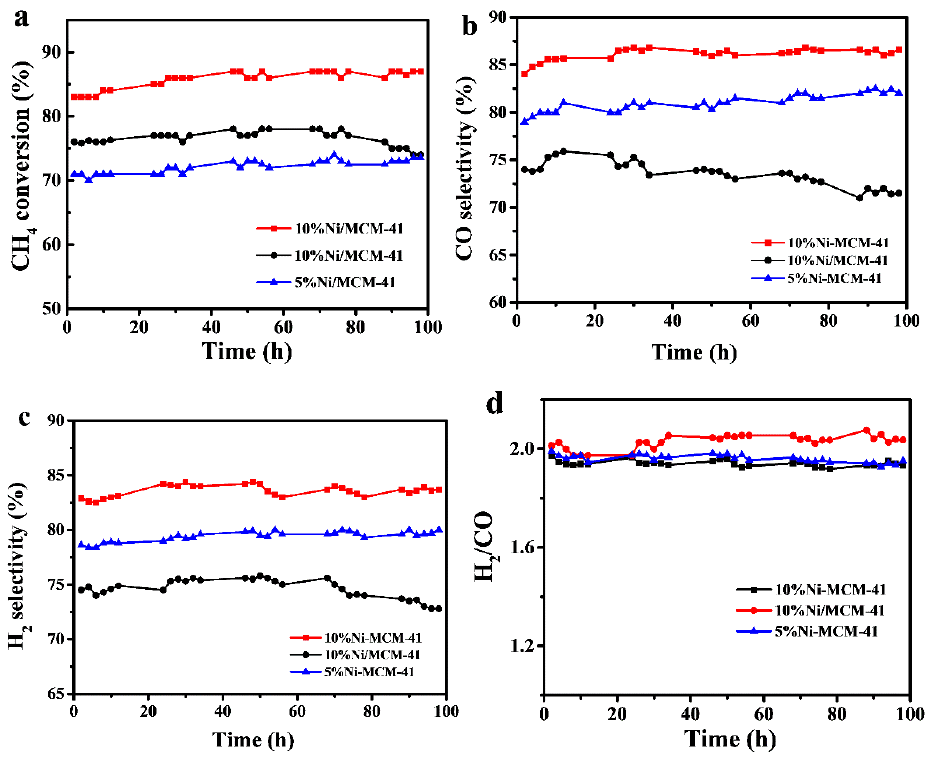
Figure 8. Stability test of 10%Ni-MCM-41 and 10%Ni / MCM-41 catalysts in POM at GHSV = 2.0 × 10 4 mL · h − 1 · g − 1 , atmospheric pressure, 800 ◦ C. ( a ) CH 4 conversion, ( b ) CO selectivity, ( c ) H 2 selectivity and ( d ) H 2 / CO ratio.